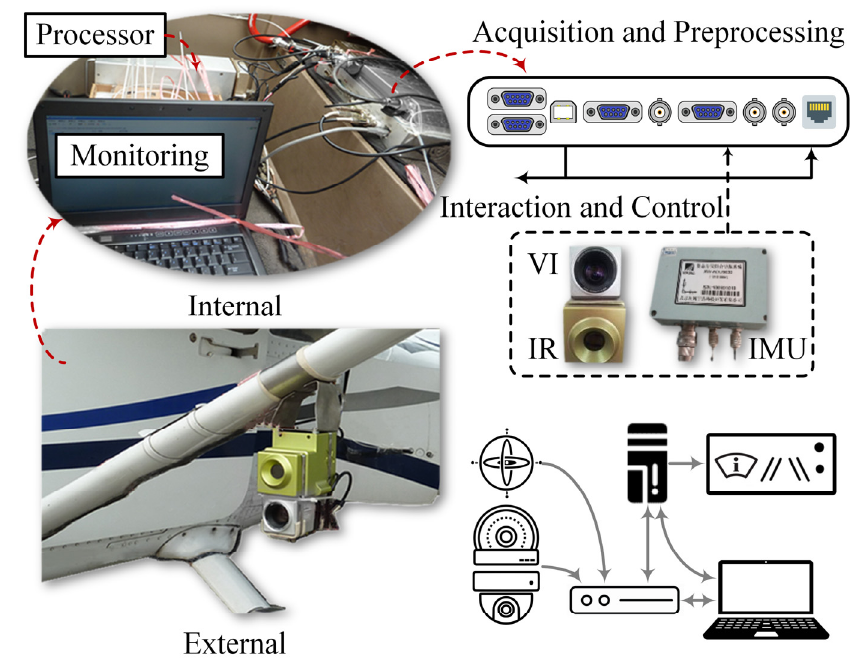
Figure 5. Flight test platform and interaction